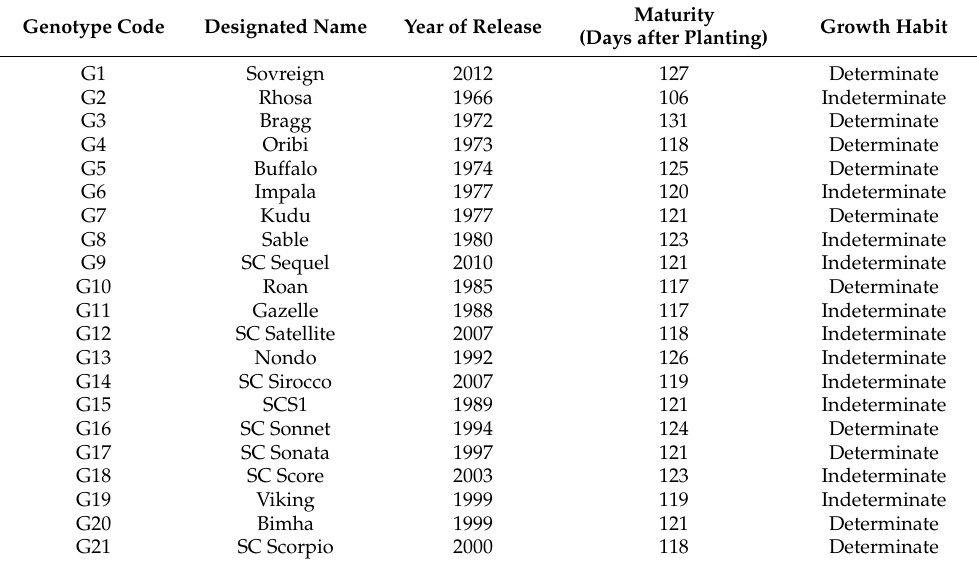
Table 1. Soybean genotypes evaluated at 13 test environments in southern